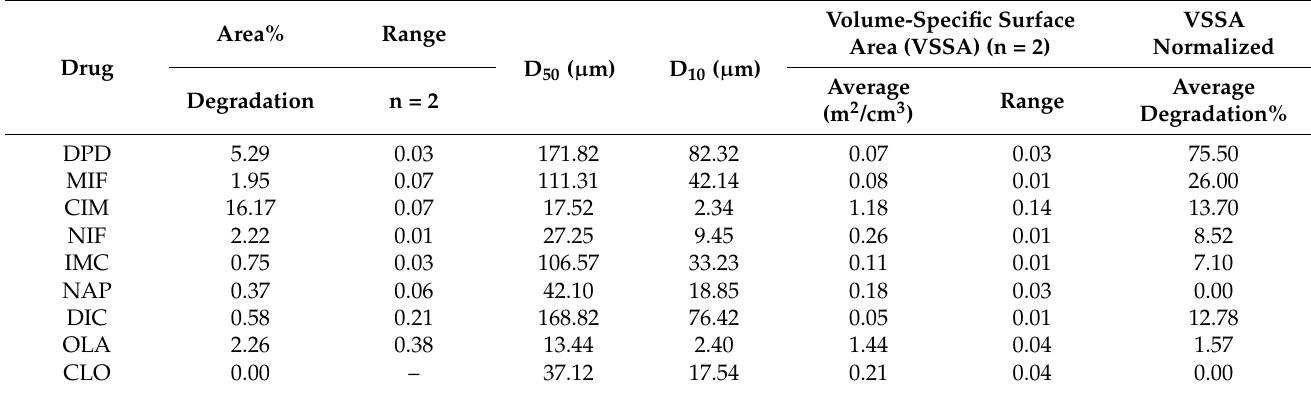
Table 2. Extent of drug degradation in RapidOxy ® and their particle size distribution, and average volume-specific surface area of selected drugs.